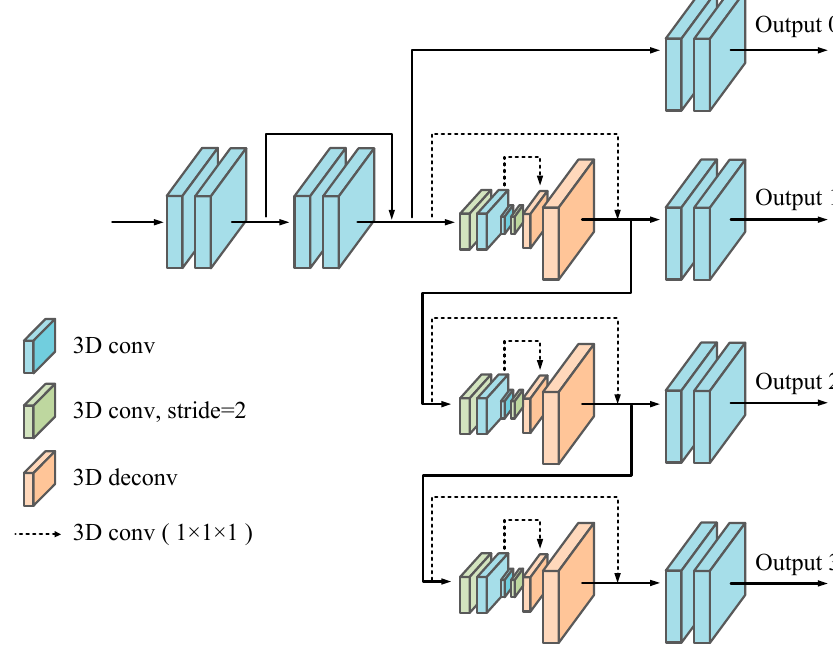
Figure 5. The detailed structure of the 3D matching net.